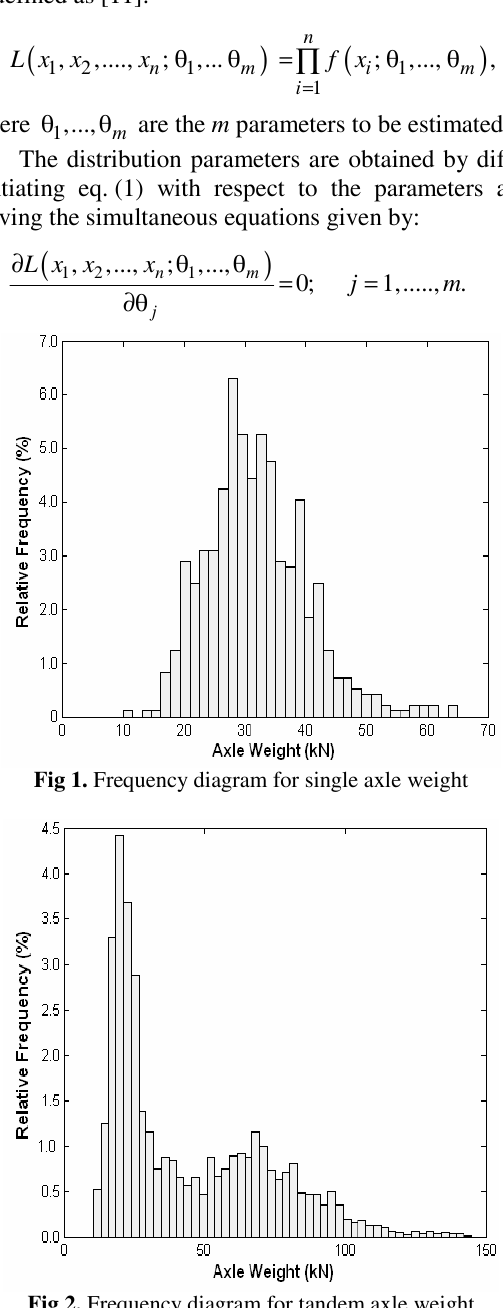
Fig 2. Frequency diagram for tandem axle weight